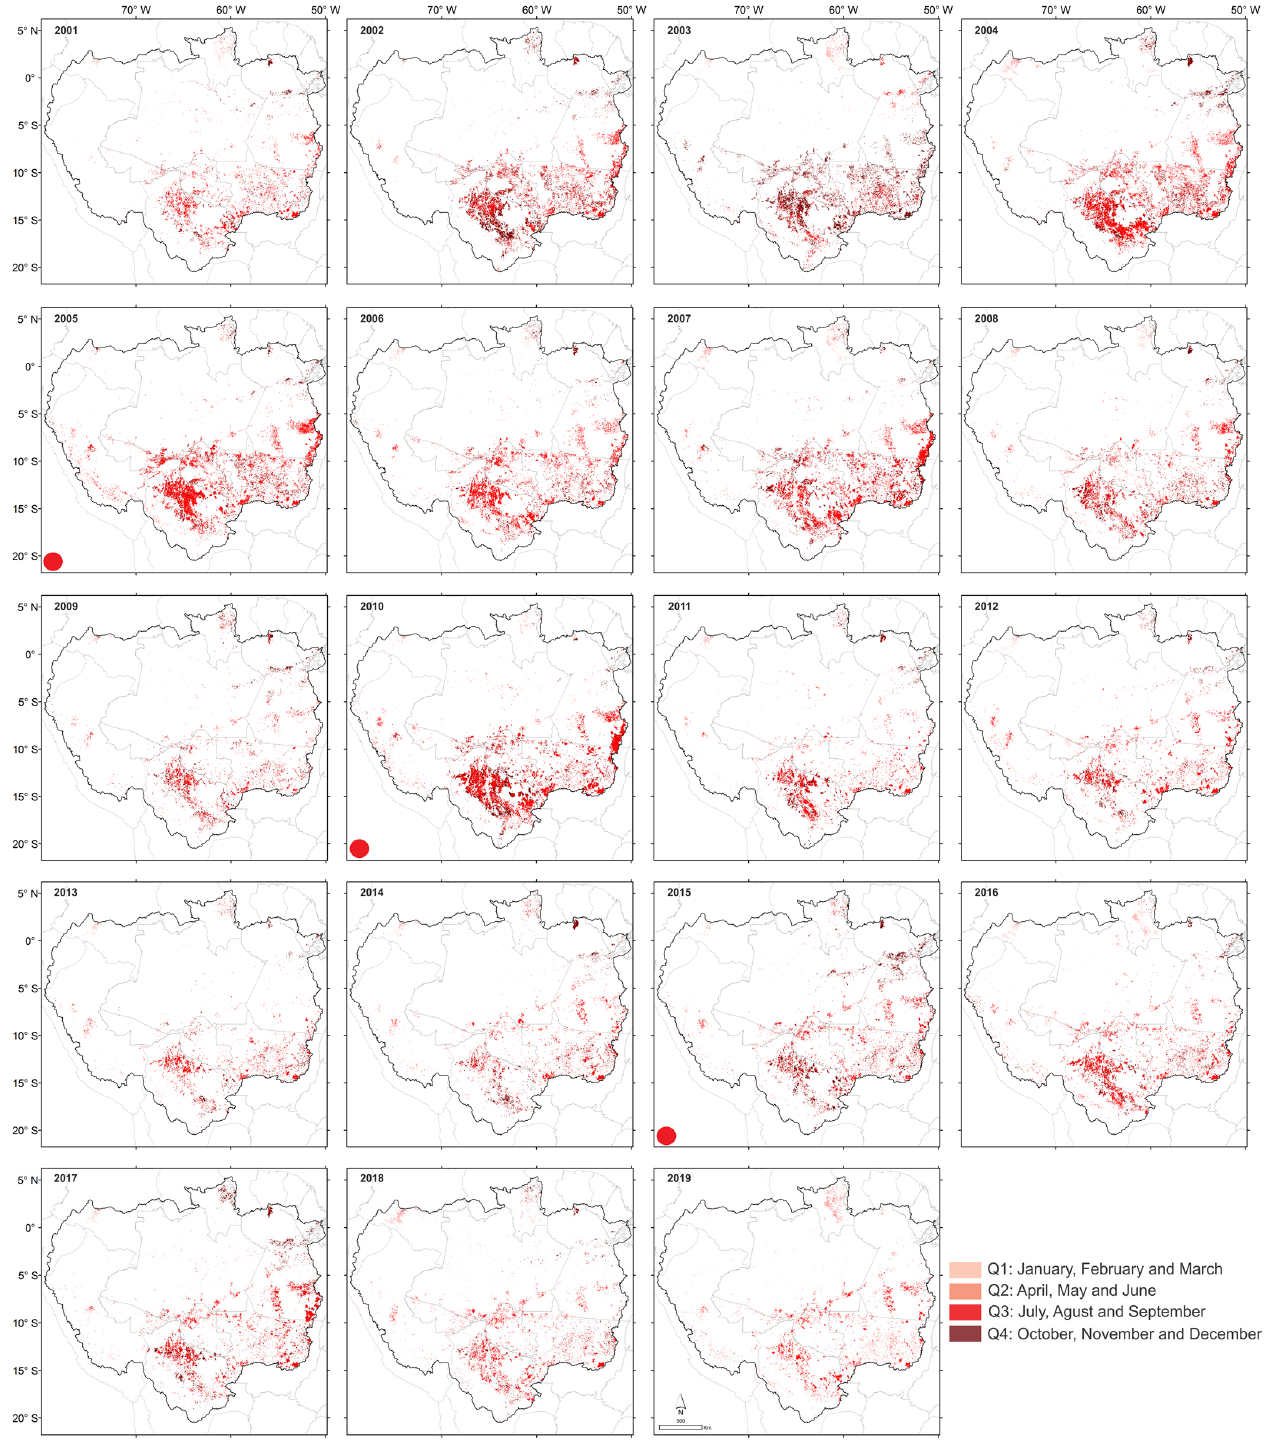
Figure 4. Identification and measurements of the annual burned areas (quarters, Q1–Q4) in the Amazon Basin based on the processed data of the product MCD64A1 (Julian days) between 2001 and 2019. Red dots indicate the occurrence of El Niño or Atlantic SST anomalies (see Figure S2).